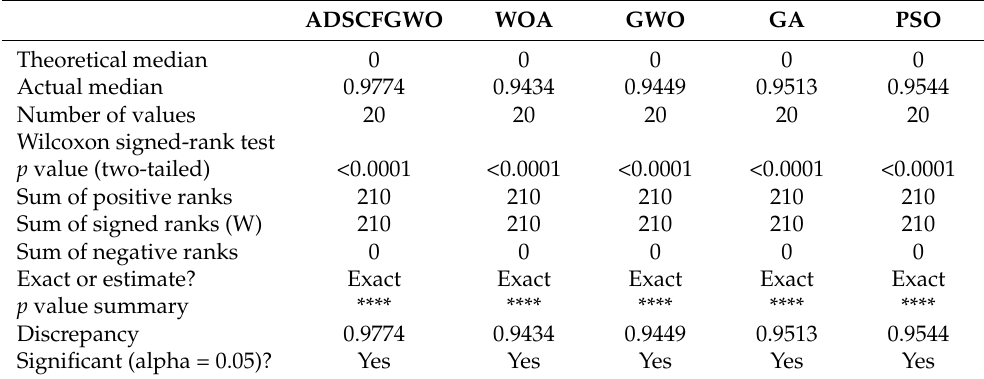
Table 12. Wilcoxon signed-rank test of the results achieved by the proposed optimized voting classifier.